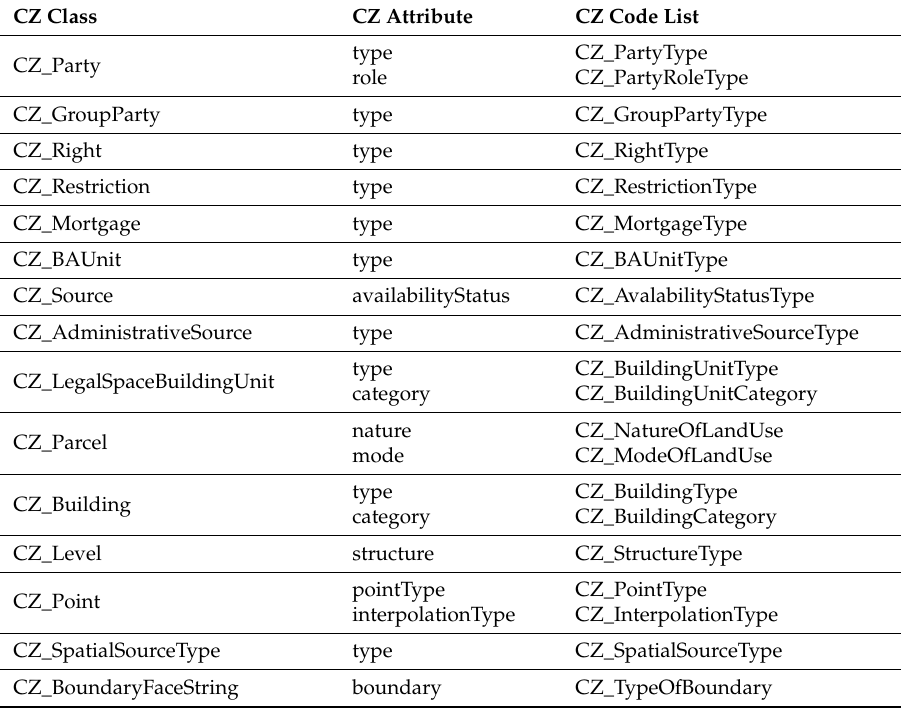
Table 3. The CZ attributes and corresponding CZ code